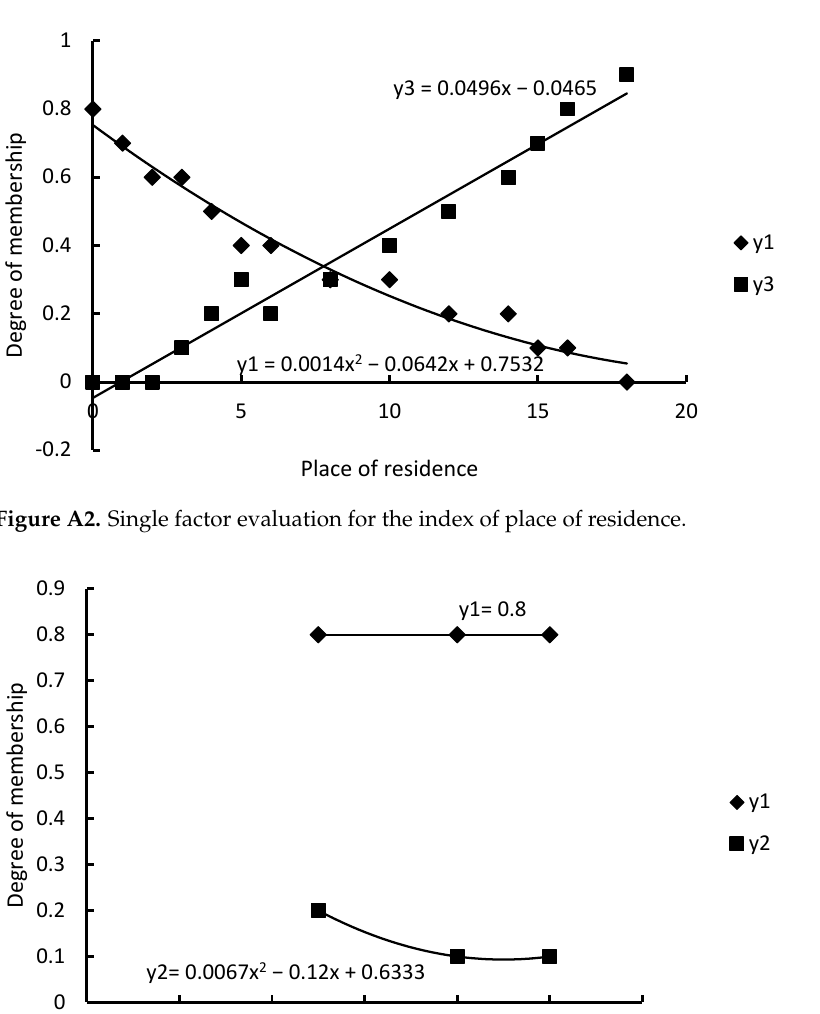
Figure A1. Single factor evaluation for the index of nationality.